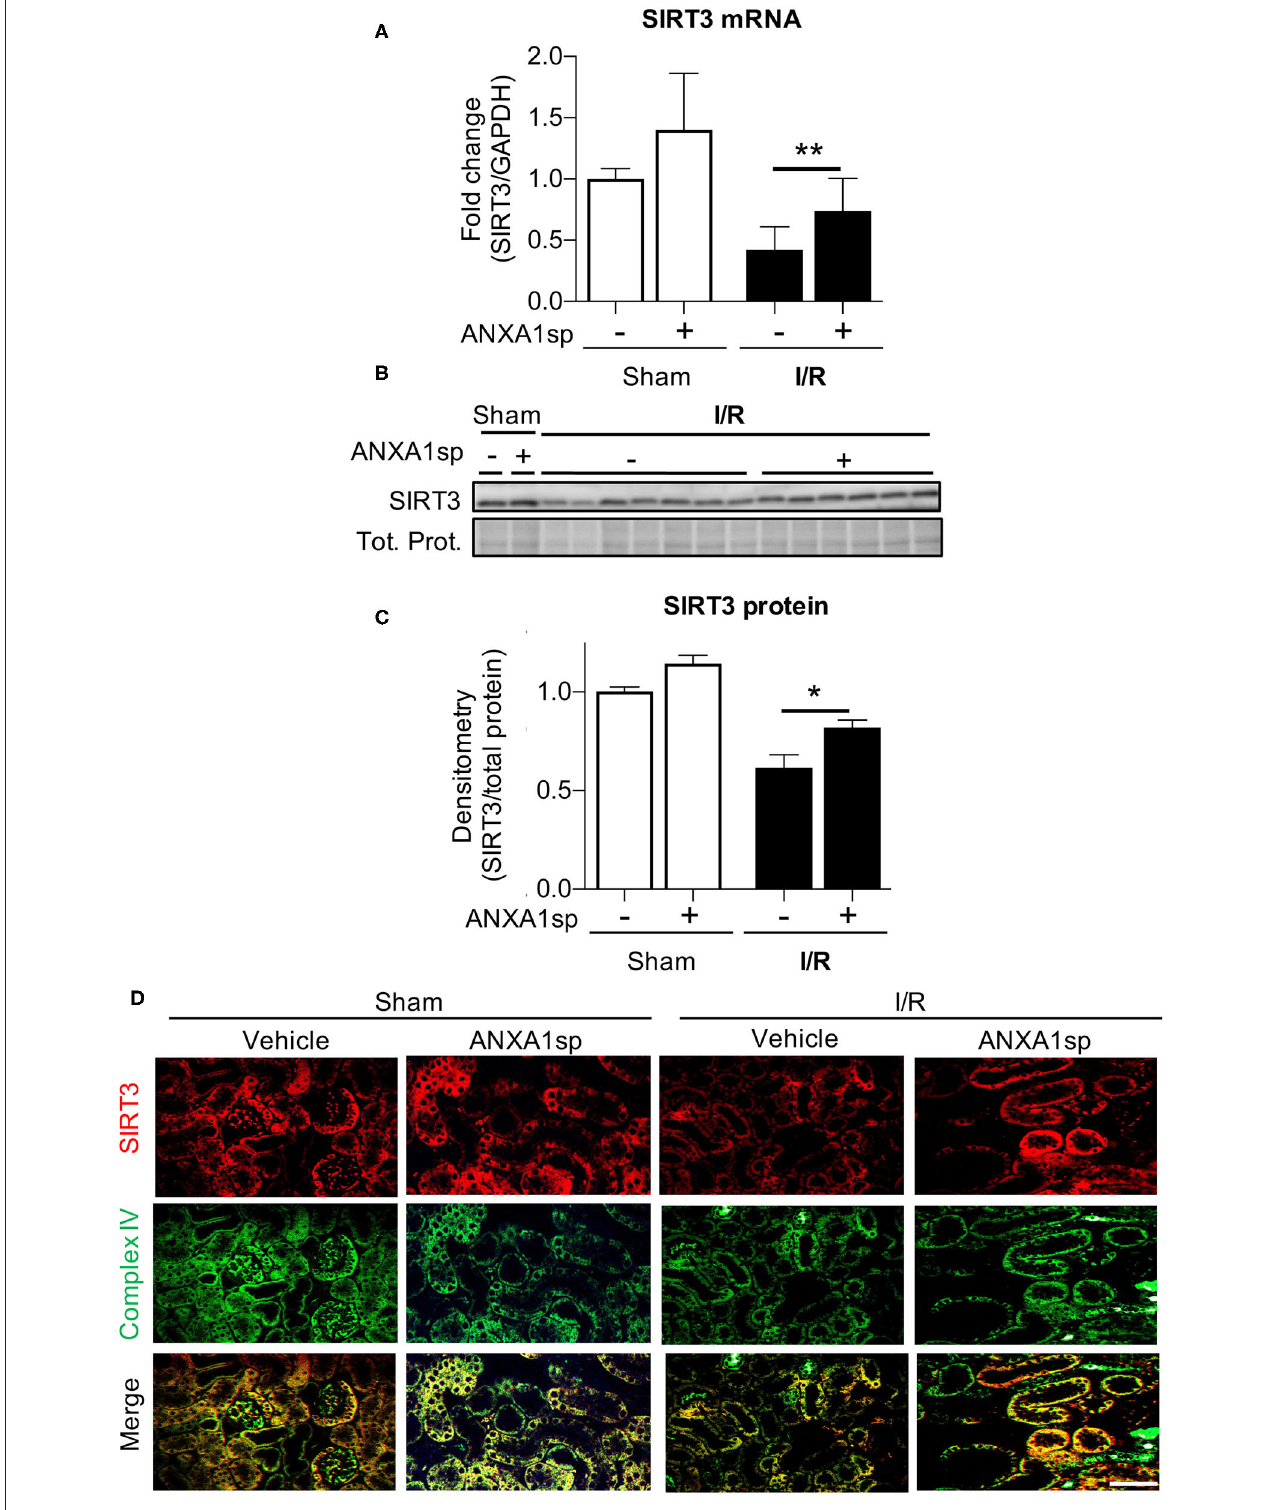
FIGURE 5 | ANXA1sp treatment upregulates levels of sirtuin3 (SIRT3) in the mitochondria of kidney tubules. Mice were treated with either Vehicle or ANXA1sp 1h prior to ischemia, subjected to 33min of unilateral ischemia and contralateral nephrectomy, and then re-injected with Vehicle or ANXA1sp 1h after reperfusion.